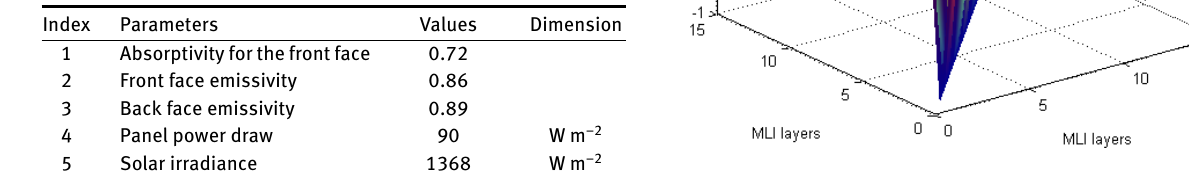
Figure 1. Initial state of D matrix (after normalization)